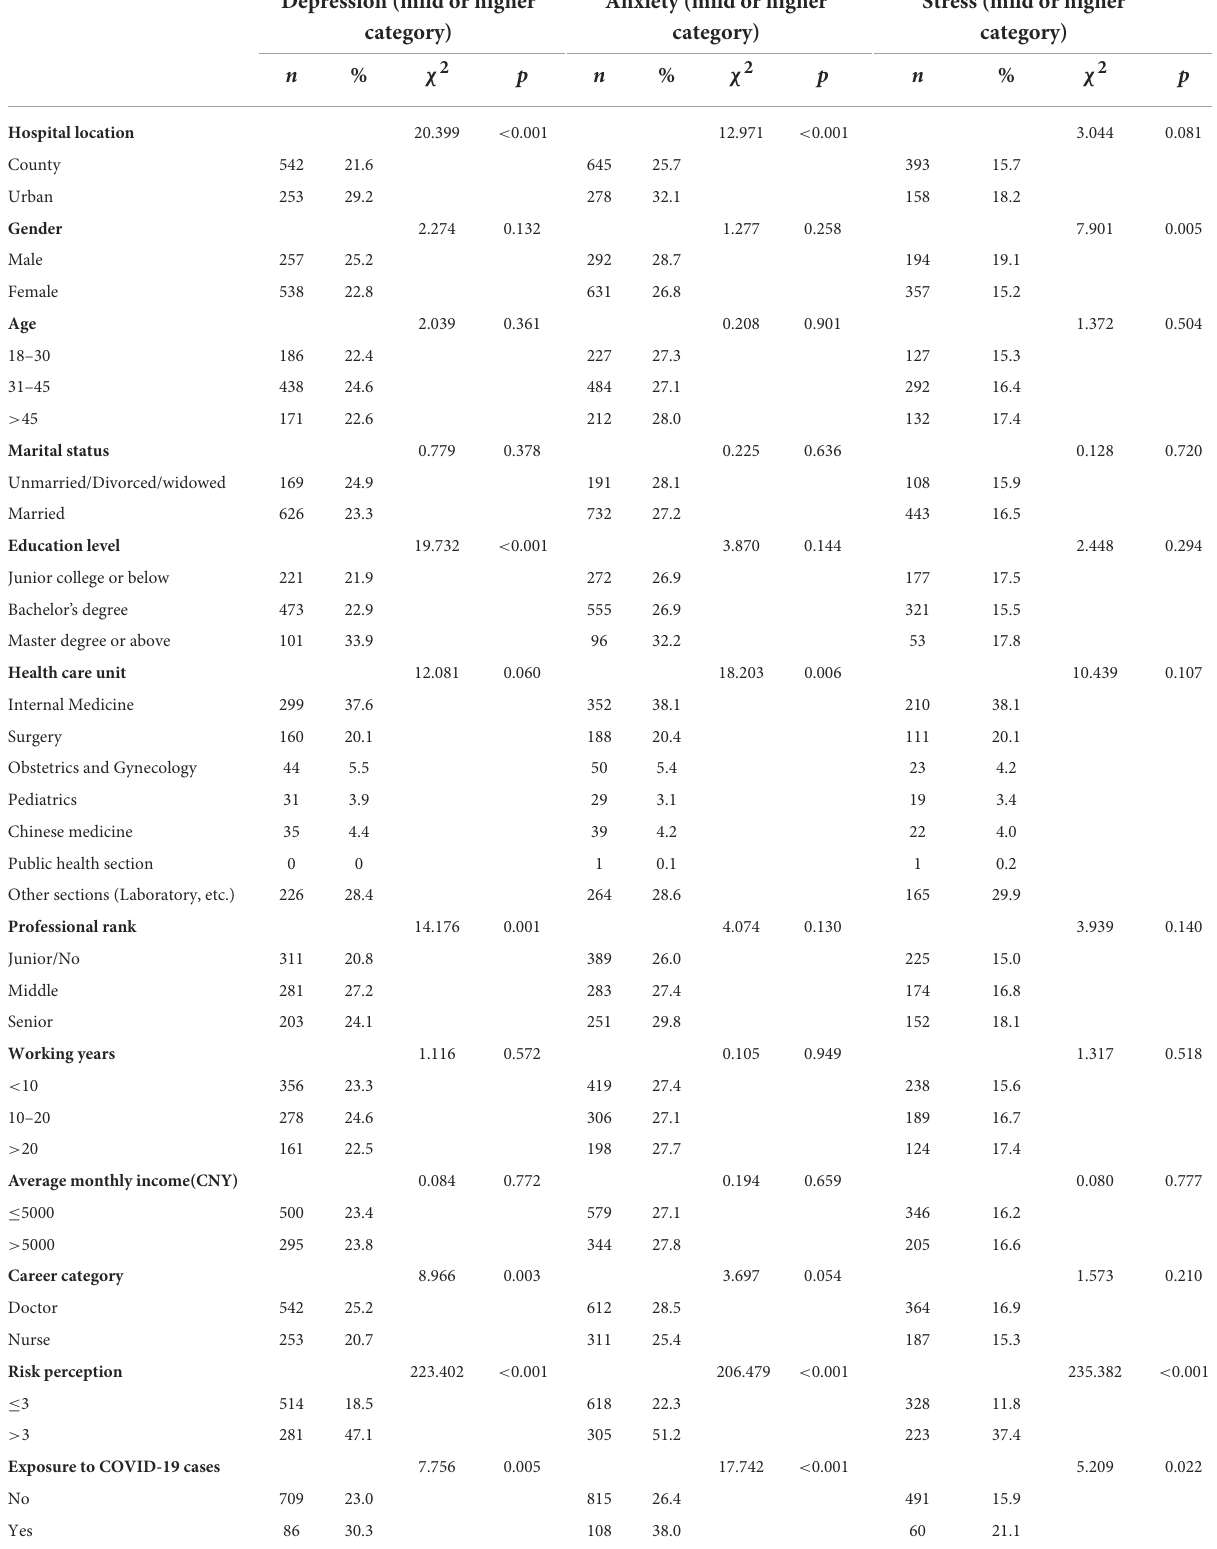
TABLE 4 Univariate analysis of symptom of depression, anxiety, and stress.